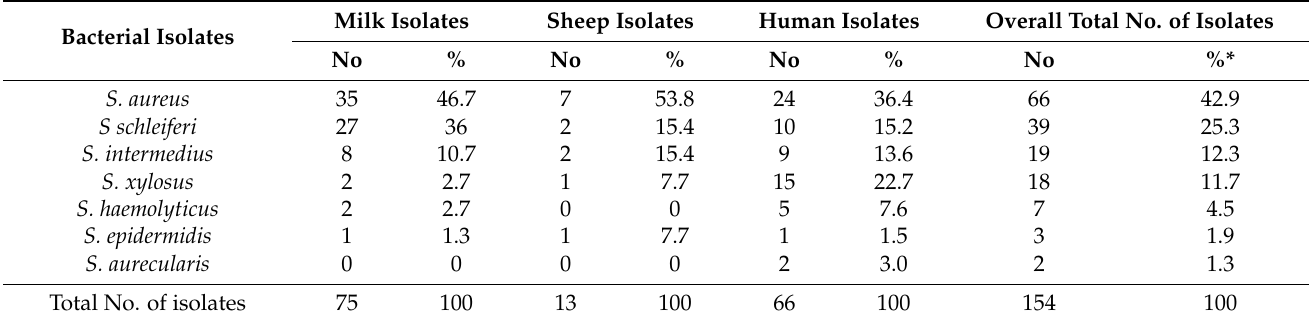
Table 2. Prevalence of different Staphylococcus spp. isolates in different examined samples.